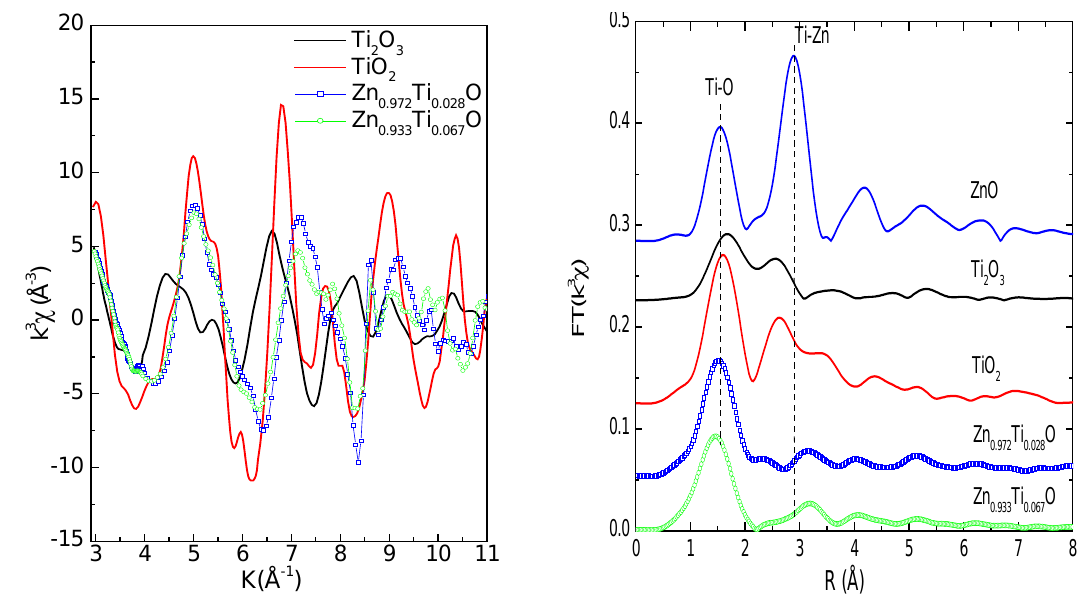
Figure 4. (a; left): Ti K -edge EXAFS functions; (b; right): Fourier Transform magnitudes (vertically shifted) of the Ti-doped ZnO films and reference Ti oxide samples. Phase shift was not